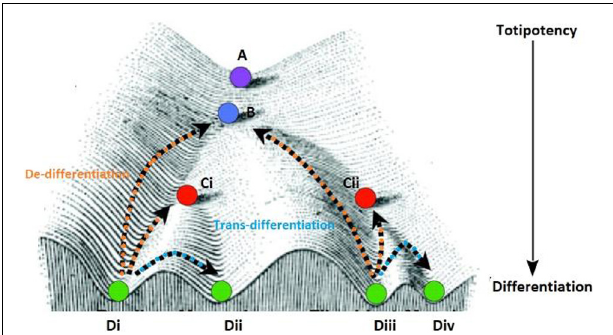
FIGURE 3 | The purple circle at the top (A) of the Waddington landscape represents a totipotent cell with the ability to differentiate into all cell lineages (B–D) present in a given metazoan system. The higher positions are representative of pluripotent zones and the low-lying zones are lineage-committed zones as denoted by the arrow. As the cell divides and travels down this landscape it retains the ability to for a select number of lineages which is dependent on the path the daughter cell takes downhill (represented by the different sub-types). All the cells represented in this figure originate from the single predecessor cell starting at position (A) and are genetically identical however, regulation of cell fate is shaped by the position phenotypic positions specified by points B,C (Ci–ii) and D (i–iv) , a cell occupies on the landscape. Each position signifies the effect of reprogramming on genetically similar cells for the expression of a fully differentiated or committed phenotype. Some cells can get arrested in a state at higher altitudes (like position B or Cii ) before the can completely differentiate and form the stem cell population, while some cells can revert to a progenitor phenotype (from the terminal phenotypic position Di to Ci ) or change positions laterally (between phenotypic position Di to Dii ) on this landscape.